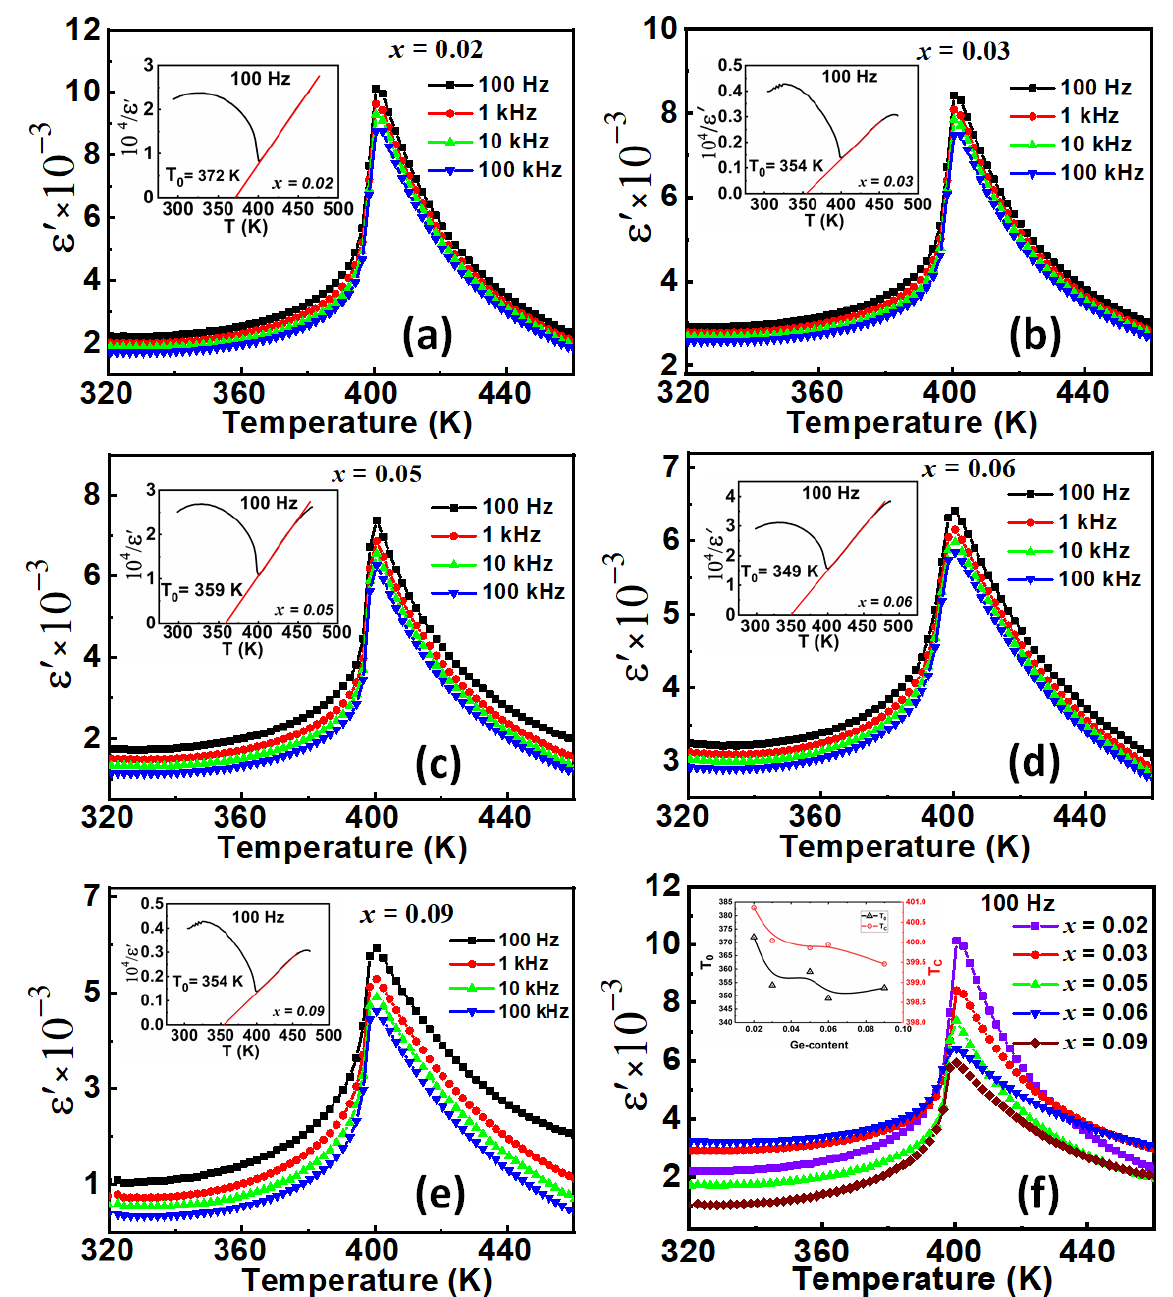
Figure 5. ( a – e ) Temperature dependence of dielectric permittivity in BGTx (x = 0.02, 0.03, 0.05, 0.06, 0.09) ceramics in the frequency range 10 2 – 10 5 Hz. Insets represent the Curie – Weiss plot of each composition. ( f ) Dielectric permittivity at 100 Hz for all the BTGx compositions. The inset shows T C and T 0 variation as a function of Ge-content. Samples globally presented a real permittivity thermal hysteresis of about 2 K, as showed in Figure 6 for the composition BTG3 recorded at 1 kHz. The inset of this figure also highlights a global weak loss factor less than 4.1%.